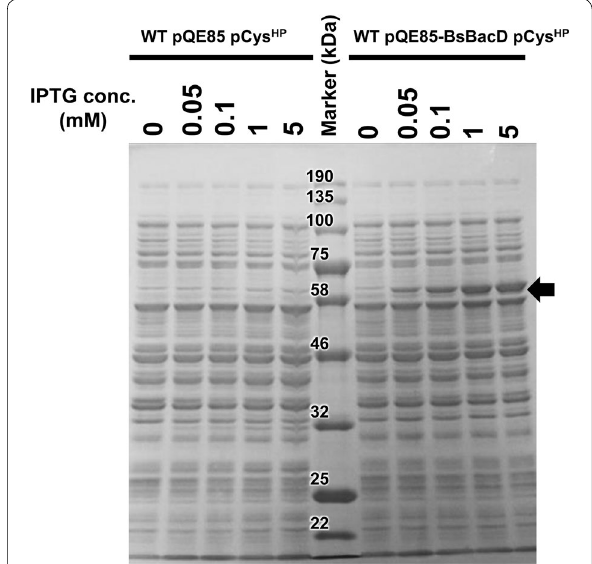
Fig. 3 SDS-PAGE analysis for confirmation of BacD expression. The supernatant (7 μg of the total protein) of cell lysate in WT pQE85 pCysHP and WT pQE85-BsBacD pCysHP was analyzed by SDS-PAGE. The protein band considered to be expressed BacD was shown by black arrow. The cell cultures for 16 h with Terrific Broth media were performed adding different IPGT concentrations (0, 0.05, 0.1, 1, and 5 mM [final concentrations]) at 3 h and it is indicated above. Protein marker size (kDa) was indicated above. For details, see “Materials and